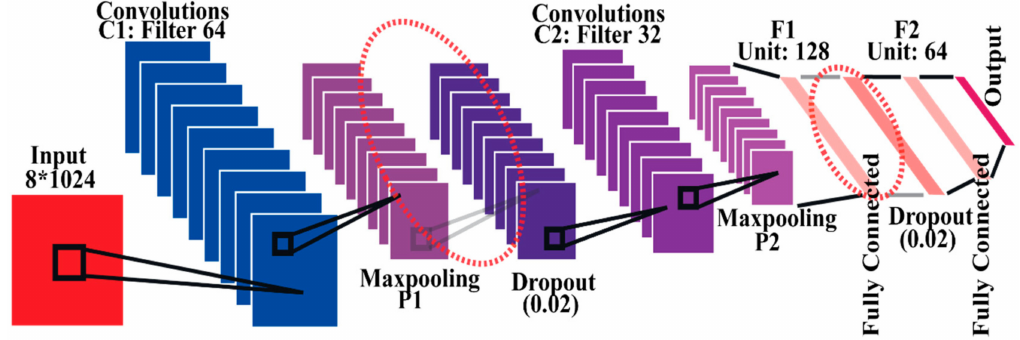
Figure 5. Proposed architecture of the 2D